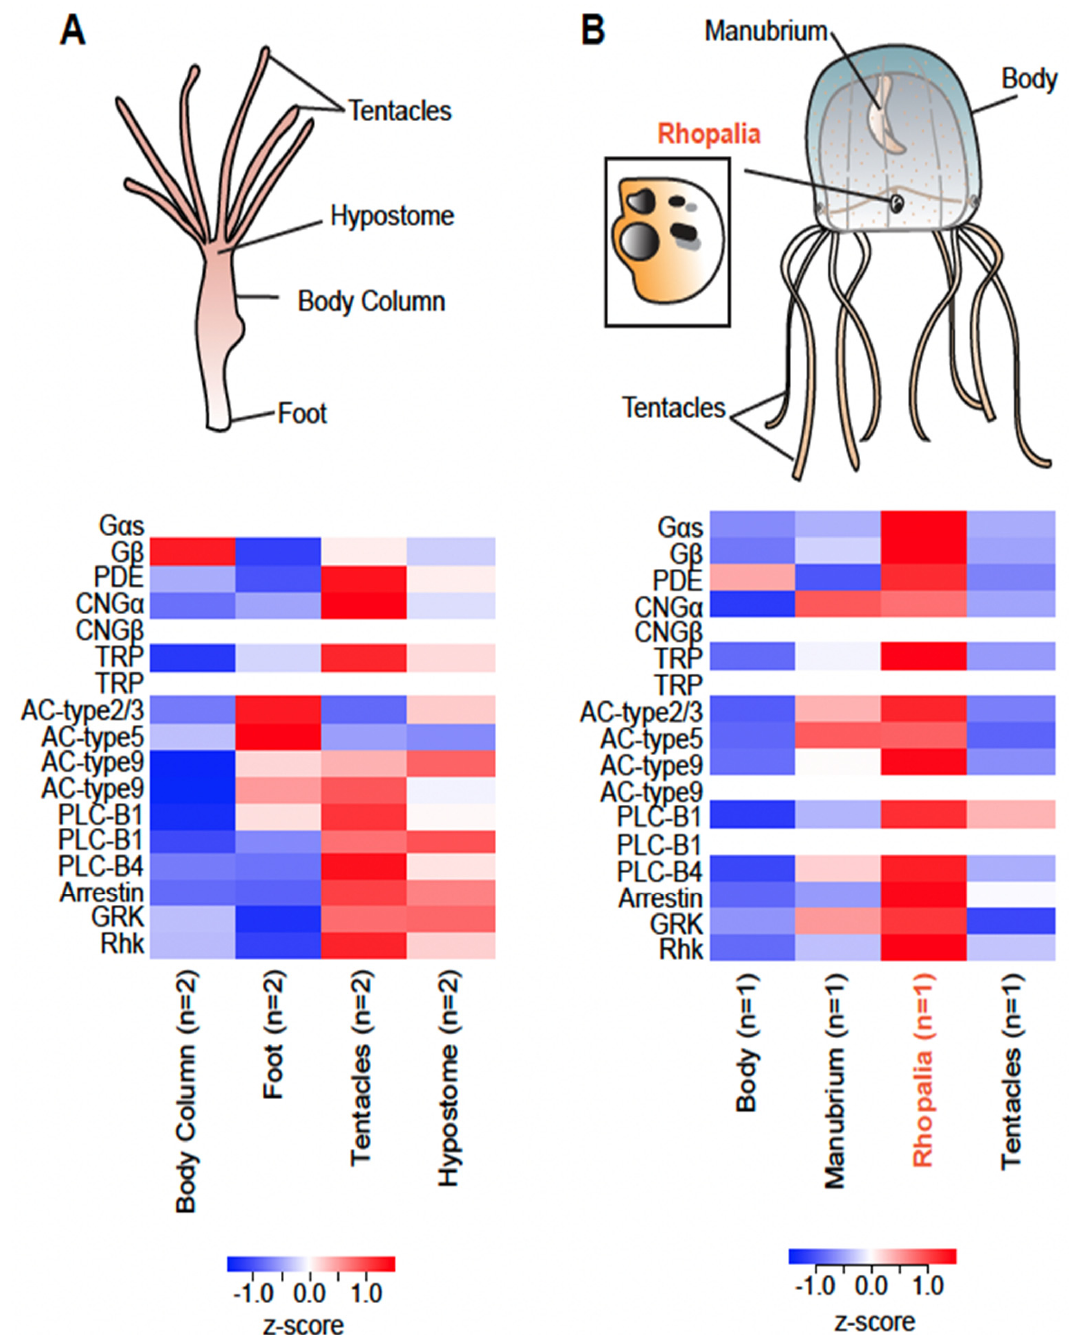
Figure 3. Expression of phototransduction gene homologs in two cnidarian species. ( A ) Top : Diagram of a Hydra vulgaris polyp. Bottom : Heatmap showing relative expression of phototransduction across tissues. Red indicates higher expression in that tissue, and blue represents lower expression. White rows represent missing genes. ( B ) Diagram of Tripedalia cystophora and its rhopalium (two lens eye, two pit eyes, and two slit eyes). Bottom : Heatmap showing relative expression of phototransduction across tissues. Table 1. Gene copies (potential duplications and loss).